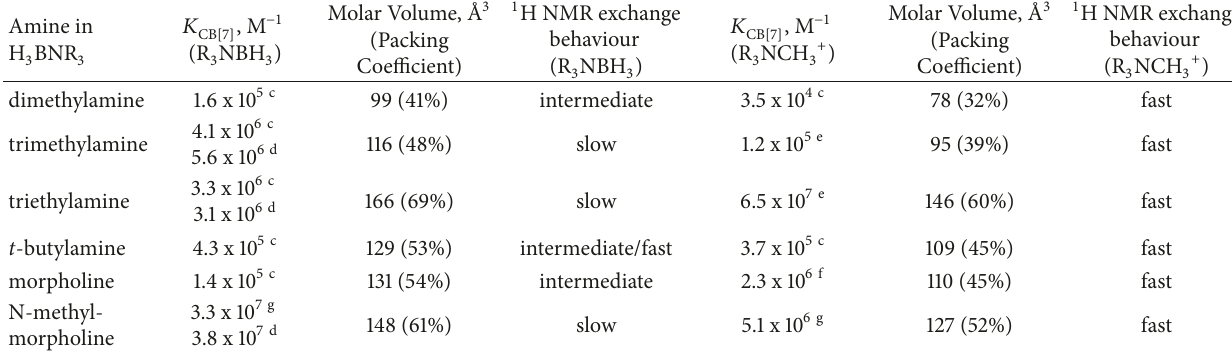
Table 1: Host-guest stability constants, a molar volumes b and packing coefficients, and the 1 H NMR exchange behaviour for the CB [7] complexes with the H 3 BNR 3 and H 3 CNR 3+ guests.